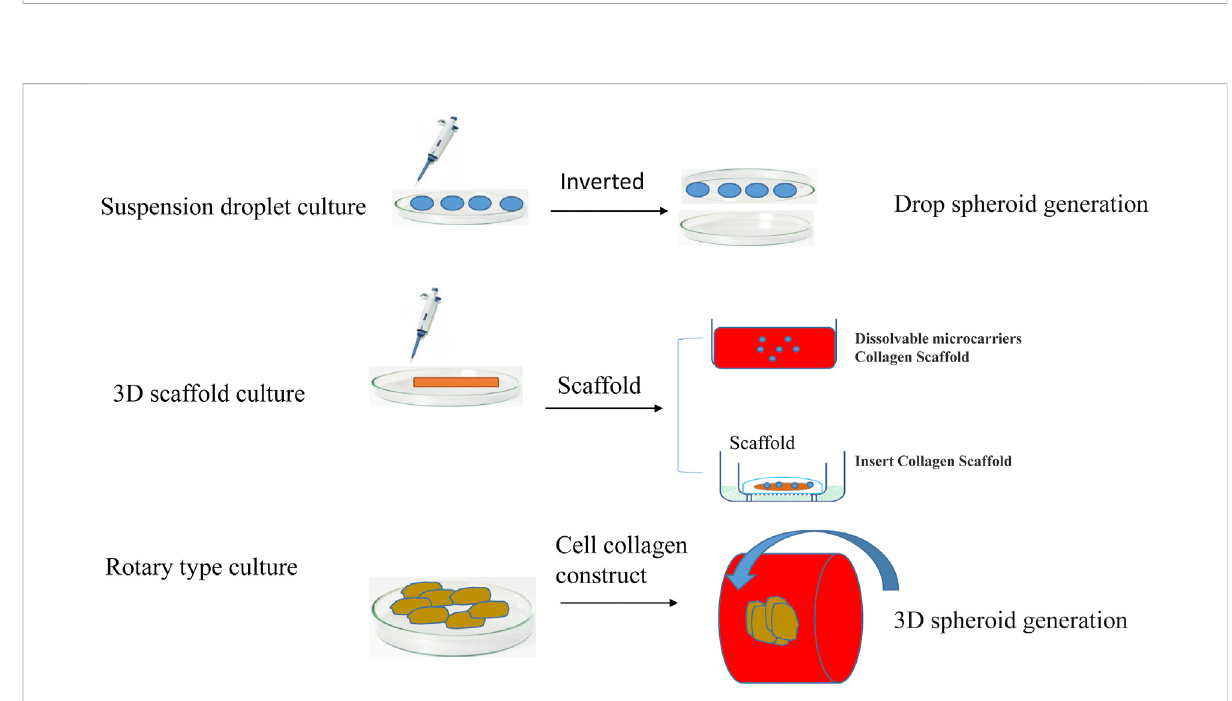
FIGURE 3 The typical spheroid formation methods and materials-based spheroid formation